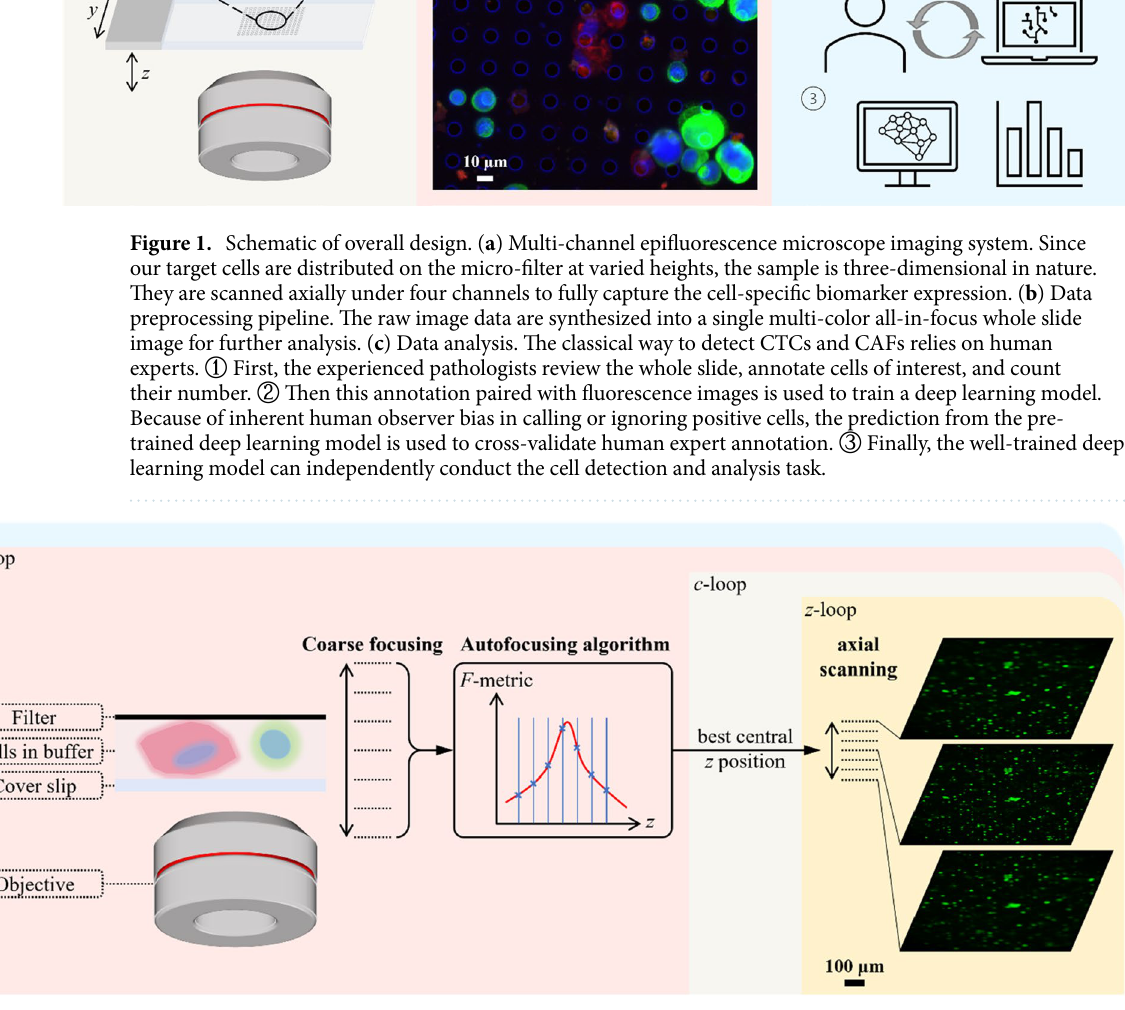
Figure 2. Auto-focusing principle during scanning. First, a coarse scanning with large step size over a wide z range is performed. Then, the image at each z position is used to calculate the focus measure ( F -metric). The best focus z position is then estimated as the peak location by fitting a Gaussian function to discrete F -metrics. Centered on this estimated best focus z position, a fine axial scanning with small step size is performed to capture the whole 3D information. Autofocusing is repeated for every lateral x – y scanning position and executed only in DAPI channel. The estimated best focus z position will be used across all channels. Chromatic aberration can be compensated by axial